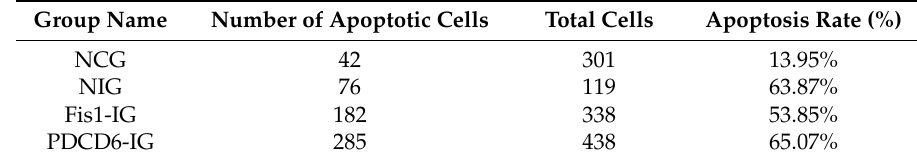
Table 1. Apoptosis rate of PSCs determined by TUNEL assay.